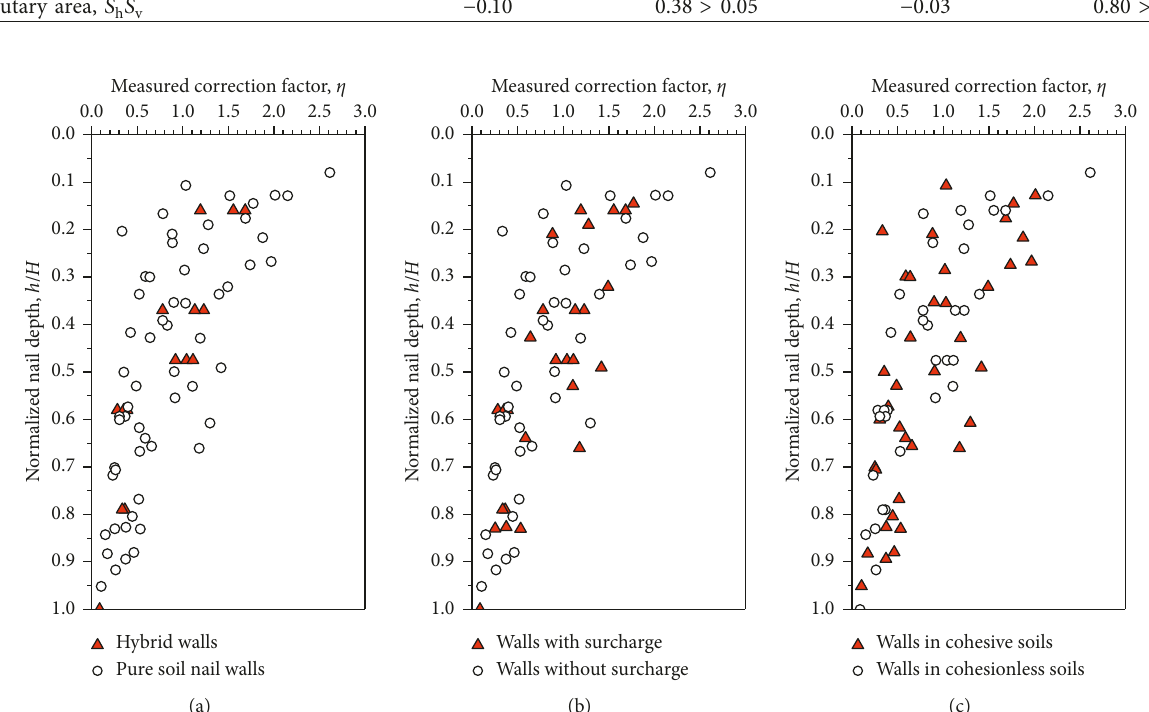
Figure 3: Measured correction factor η versus normalized nail depth h/H for different data subsets grouped based on soil nail wall-working